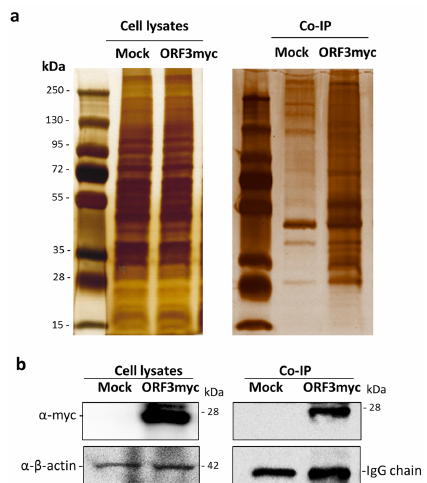
Figure 1. SDS-PAGE and western blot analysis of immunoprecipitated samples. ( a ) Plasmid expressing ORF3myc was transfected into HEK293T cells. Empty plasmid was used as mock transfected. At 24 hpt, cell lysates were harvested and subjected to immunoprecipitation with anti-myc a ffi nity beads. The pull-down proteins were separated by 10% SDS-PAGE and visualized by silver staining. ( b ) The pull-down proteins were transferred onto nitrocellulose membrane for western blot analysis. Rabbit anti-myc antibodies were probed to detect ORF3 expression in transfected cells and immunoprecipitated sample. Mouse anti- β -actin and -myc antibodies were used to detect β -actin and myc IgG as internal controls.